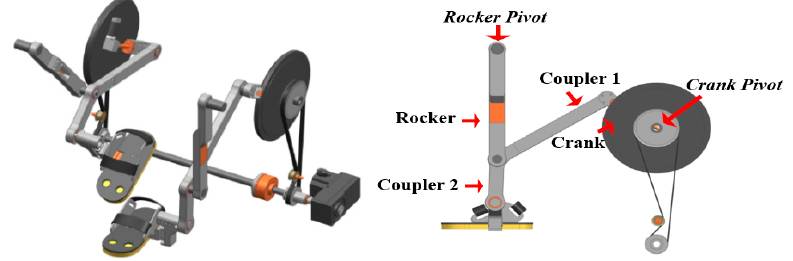
Figure 1. Concept of gait rehabilitation prototype and five-bar linkage mechanism.